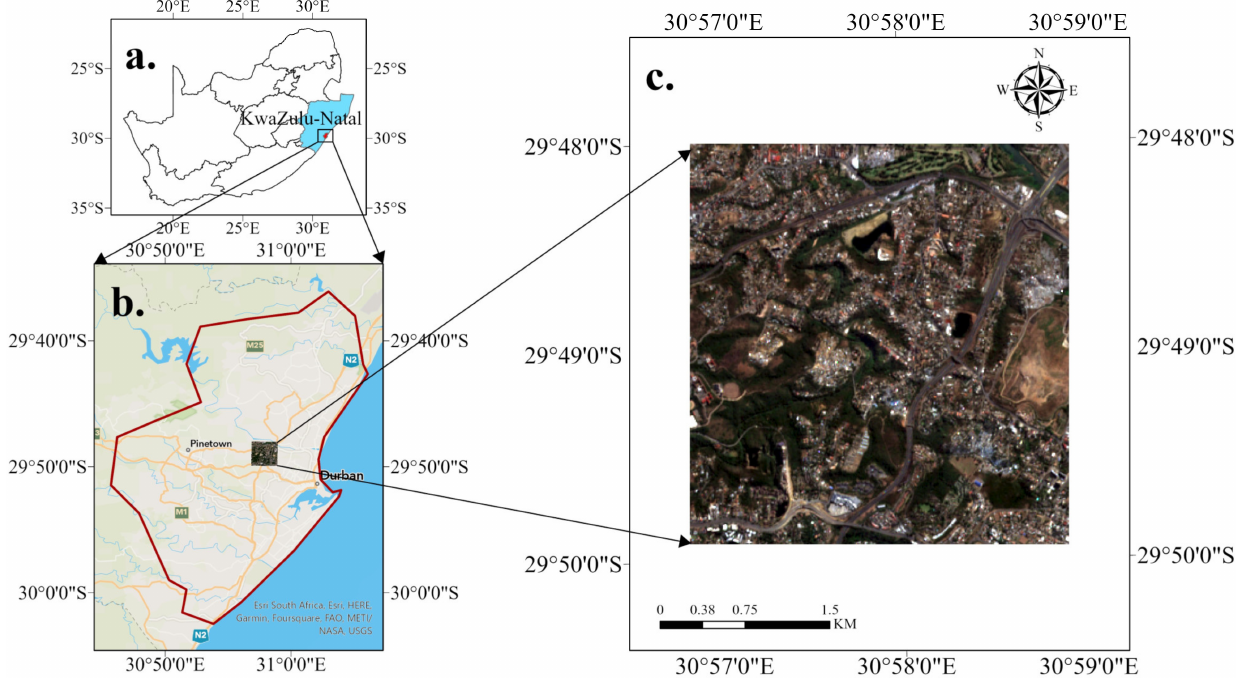
Figure 1. Study area selected in KwaZulu-Natal province ( a ), within Durban Metropolis ( b ), South Africa, ( c ) is the overview of the area obtained with an RGB PlanetScope imagery, in UTM/WGS84 plane